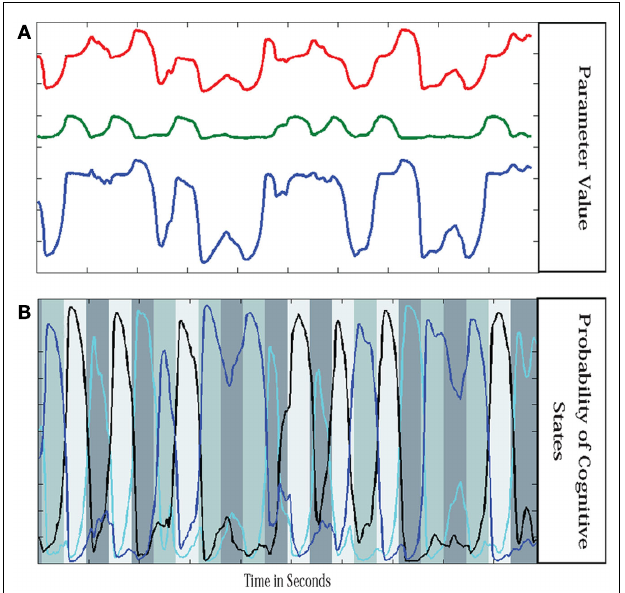
FIGURE 3 | Parameter values in switching linear dynamic system. Shown are the parameter values for three regions (A) and the probability of each cognitive regime (B) . Parameters are mixtures of the stationary models from each regime weighted by the probability of being in each regime.The connectivity parameter values are similar but not identical for repetitions of the same condition and the parameters vary within a block of the same condition as well. However the main source of variance in the parameters is the change from condition to condition.